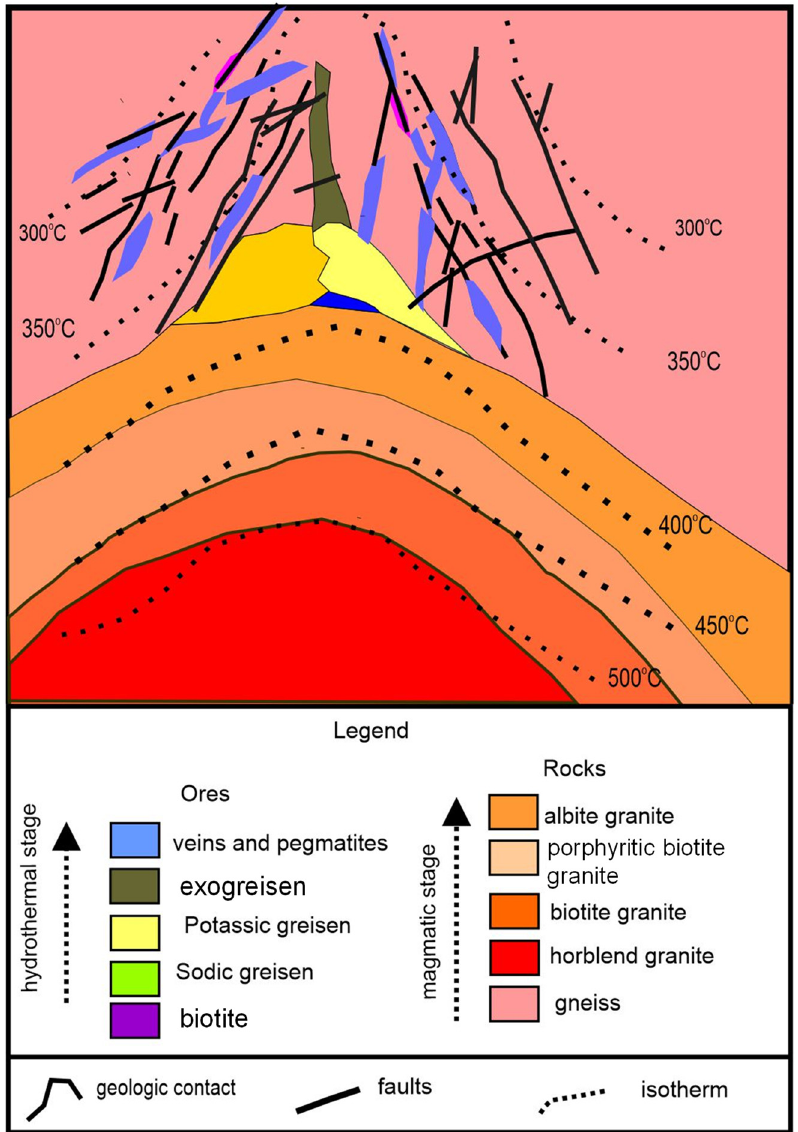
Figure 23. Schematic model of the rocks and fluids responsible for generating rare metal mineralizations in the Massangana Massif.